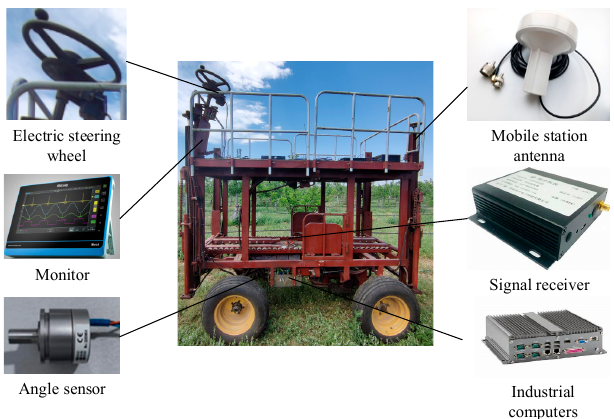
Figure 14. Components of the automatic navigation system.